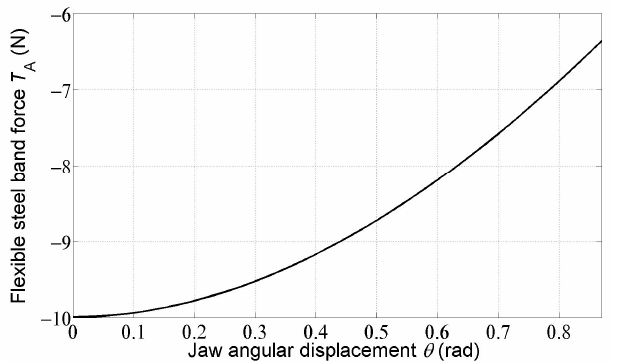
T on the jaw angular displacement θ . A